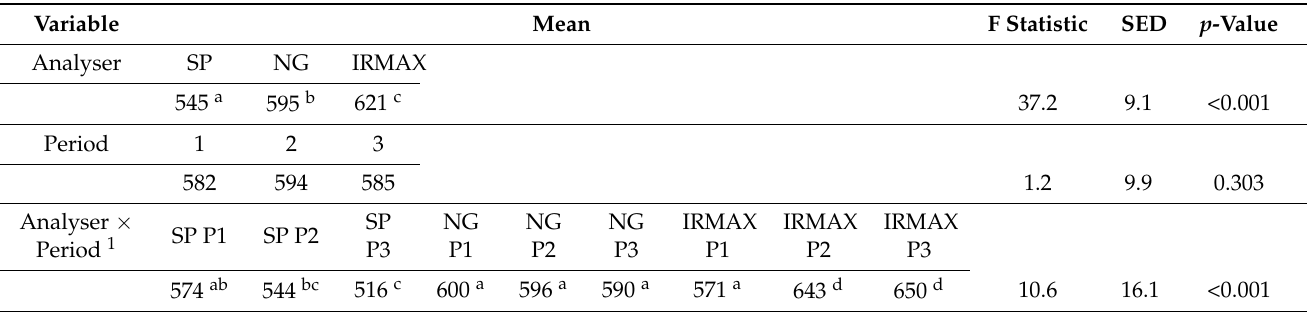
Table 2. Effect of analyser (SP, NG or IRMAX) and period on methane concentration (ppm). Means with different superscript letters in the same row differ ( p < 0.05).